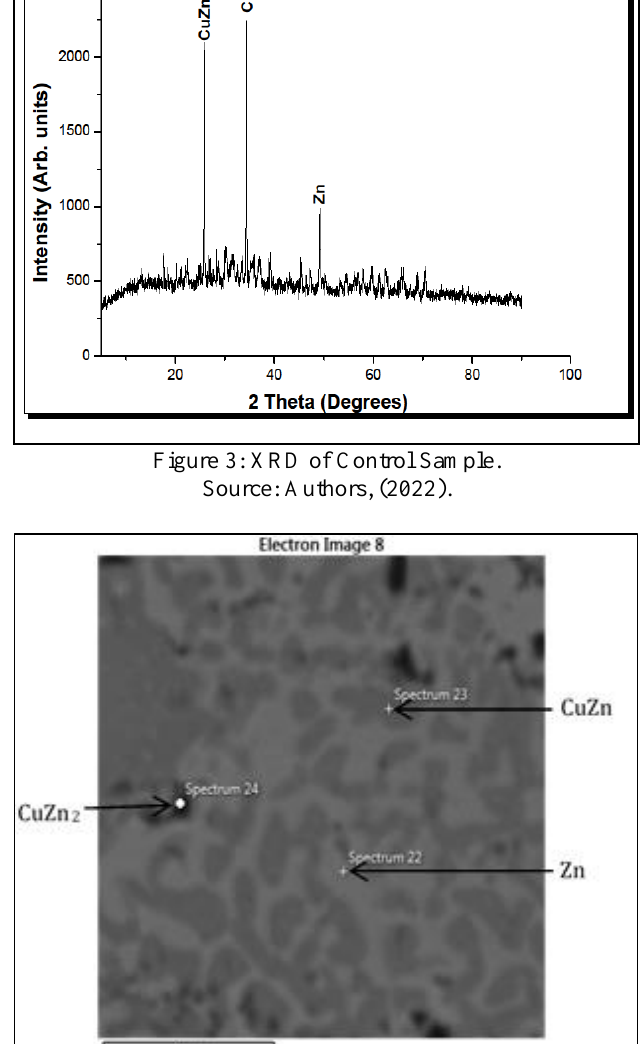
Figure 4: SEM Micrograph of Control